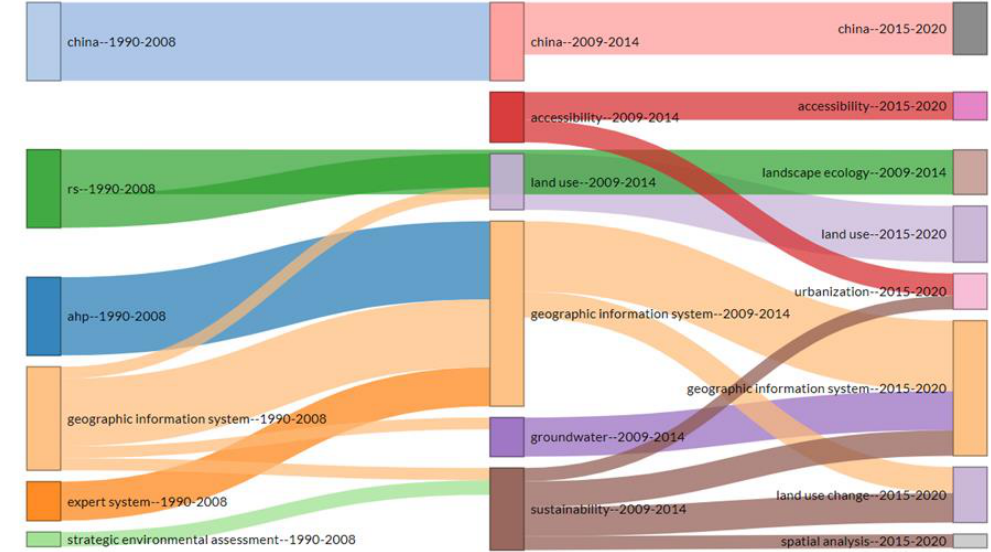
Figure 4. Map of behavior and thematic evolution.